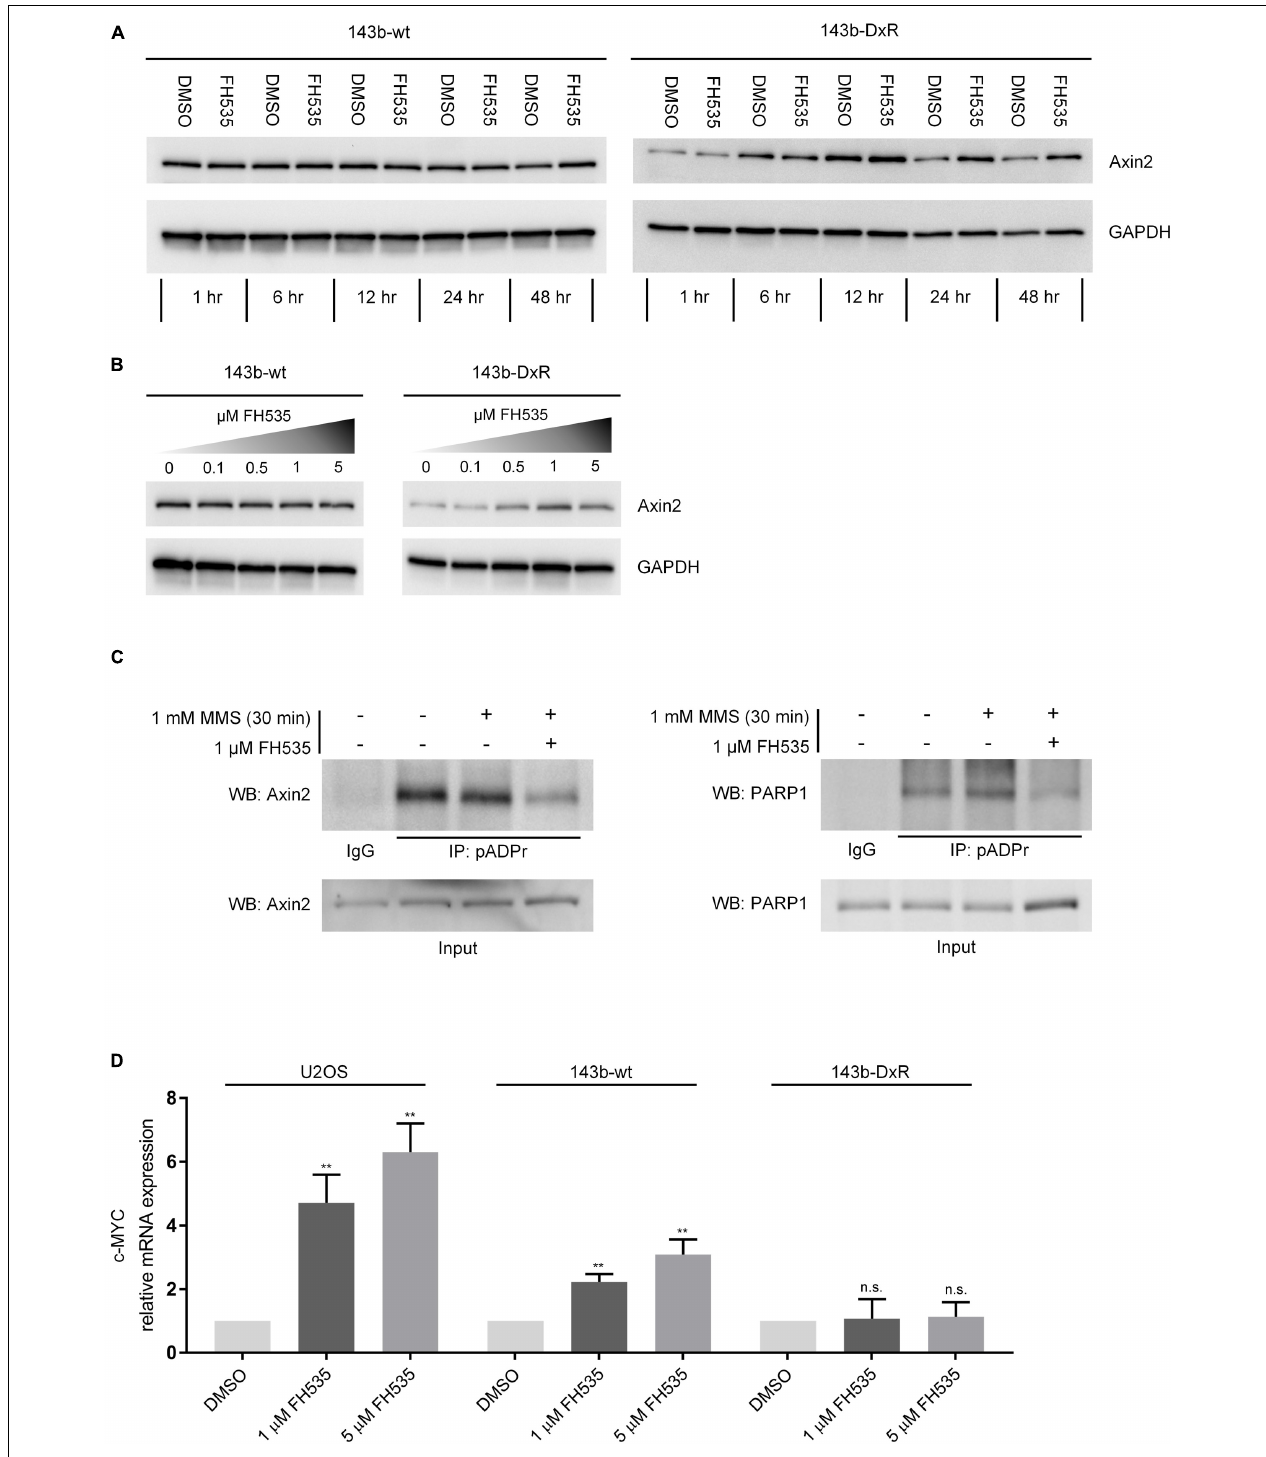
FIGURE 4 | FH535 inhibits PARylation by TNKS and PARP1. (A) Axin2 protein expression over time during treatment with 1 µ M FH535 in 143b-wt and 143b-DxR cell lines. (B) Axin2 protein expression in 143b-wt and 143b-DxR cell lines after 48 h treatment with increasing doses of FH535. (C) Immunoprecipitation for pADPr in the 143b-DxR cell line following treatment with 1 µ M FH535 for 48 h. (D) Expression of c-MYC mRNA after 24 h treatment with FH535 in 143b-wt, U2OS, and 143b-DxR cell lines. ( n = 3). Data information: in (A–C) , figures shown are representative images of triplicate experiments. (D) Data are presented as mean, ± SD. Statistical significance determined by one-way ANOVA with Tukey’s multiple comparison test, ∗∗∗∗ indicates p < 0.0001, “n.s.” indicates no statistically significant difference.